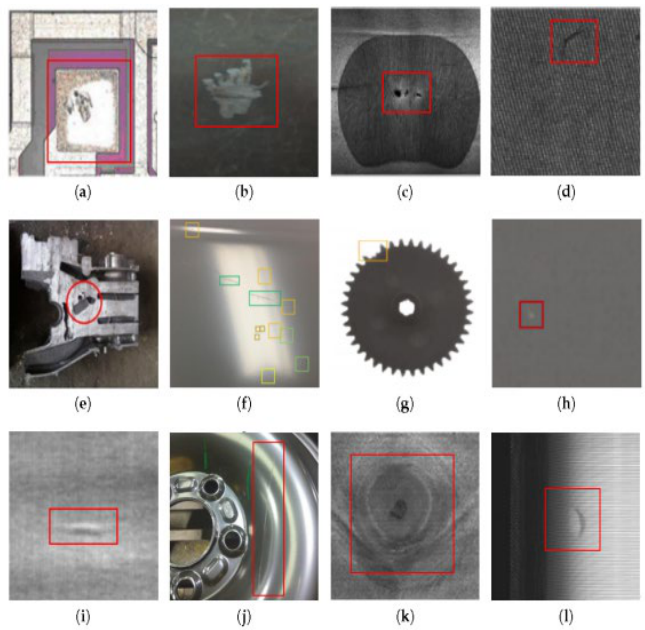
Figure 9. Defects in different areas: ( a ) metallization peels off of electronic components. ( b ) pipeline corrosion. ( c ) defective with gas pore. ( d ) defect big knot of textile materials. ( e ) shrinkage and porosity defect of Casting. ( f ) In the car body, defects in green, yellow, and orange bounding boxes are scratch, cratering, and hump. ( g ) Lack of defect of gear. ( h ) light leakage defect on mobile screen [25]. ( i ) Convexity defect in aluminum foil. ( j ) Scratch defect of the wheel hub. ( k ) Branch defect of wood veneer. ( l ) Bubble defect of the tire sidewall [87].